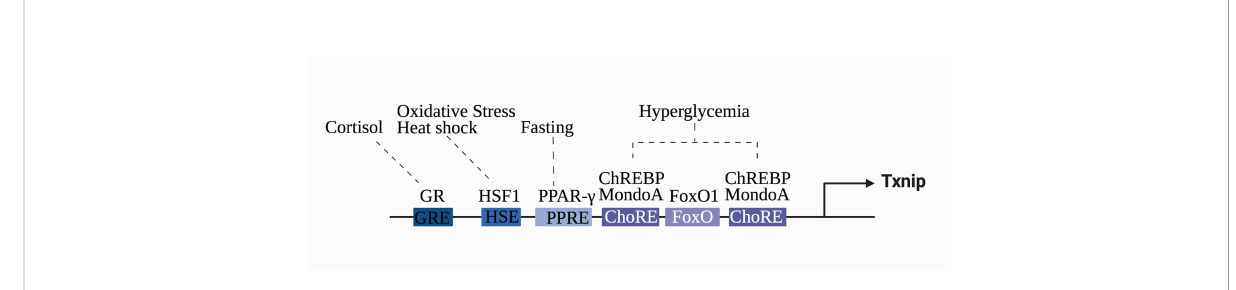
FIGURE 1 Transcriptional regulation of the TXNIP gene. TXNIP gene expression is regulated by various regulatory elements, transcription factors, and receptors. The different stimuli correspond to the respective transcriptional factors and binding sequences. Glucocorticoid-glucocorticoid